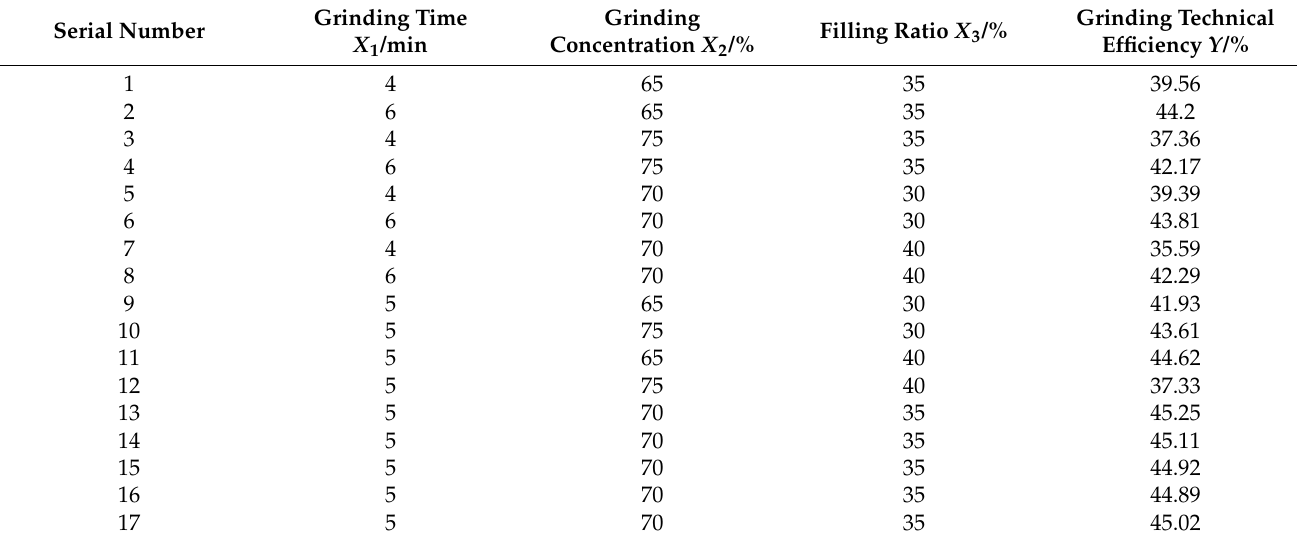
Table 13. Experimental design and result of response surface